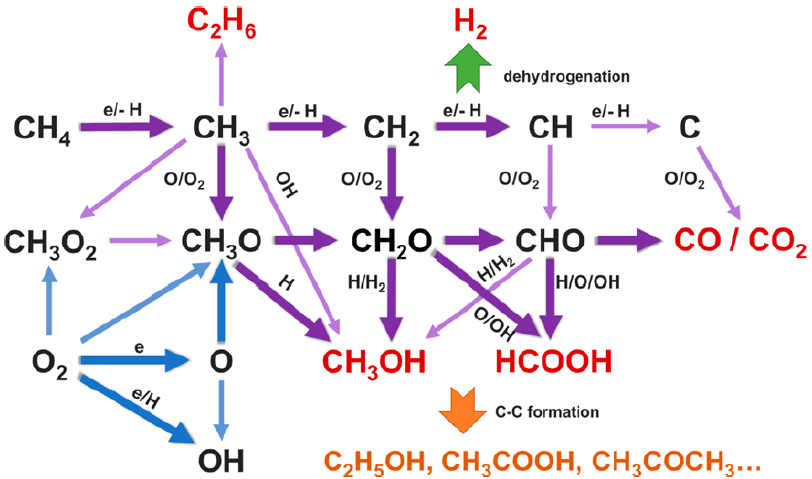
Figure 21. Proposed reaction pathways in the plasma-only reaction of CH 4 /O 2 towards CH 3 OH and other oxygenates or hydrocarbons. (Red: Main products, Orange: C 2+ oxygenates). Reproduced with permission from [118]. Copyright 2021 Elsevier.